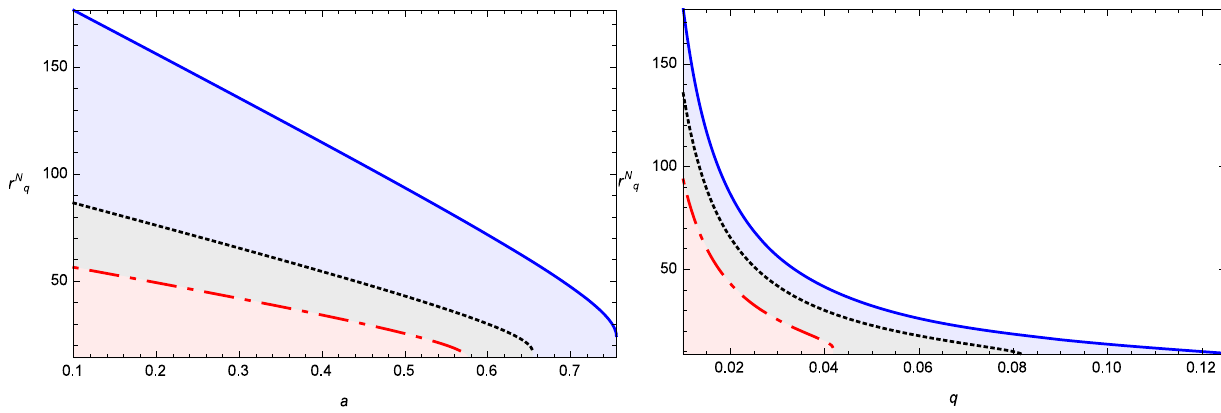
Fig. 11 Shows the graphic analysis of r N . The left panel represents q = 0 . 01 (blue), q = 0 . 02 (black), and q = 0 . 03 (red). The right panel b represents a = 0 . 1 (blue), a = 0 . 3 (black), and a = 0 . 5 (red)